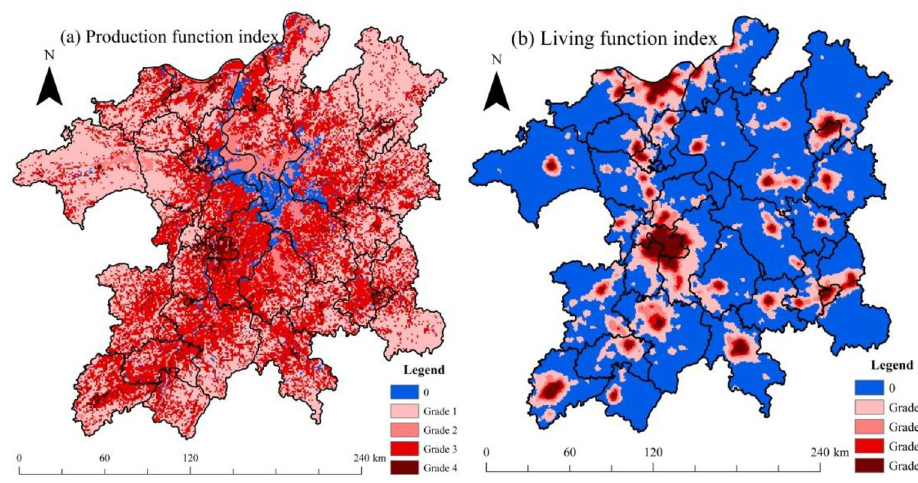
Fig 4. Intensity grades of regional production and living function index in the